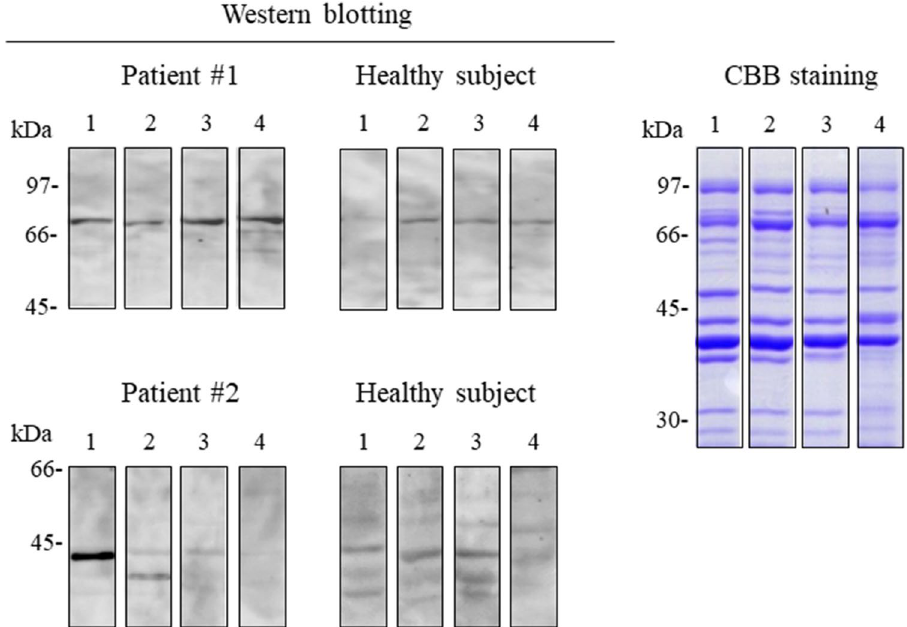
Figure 2. Immunoblot analysis of Tris-soluble shrimp proteins from two shrimp and two prawn species. Samples of the Tris-soluble fraction (10 μg) from L. vannamei, P. monodon , M. japonicus, and F. chinensis (lanes 1, 2, 3, and 4, respectively) were separated by SDS-PAGE and stained with CBB or immunoblotted with 1:10 dilutions of sera from two shrimp-FDEIA patients (patient no. 1 for 70-kDa protein and no. 2 for 43-kDa protein). Each blot was cropped from the same membrane and rearranged. Full-length blots and a gel are presented in Supplementary Figure